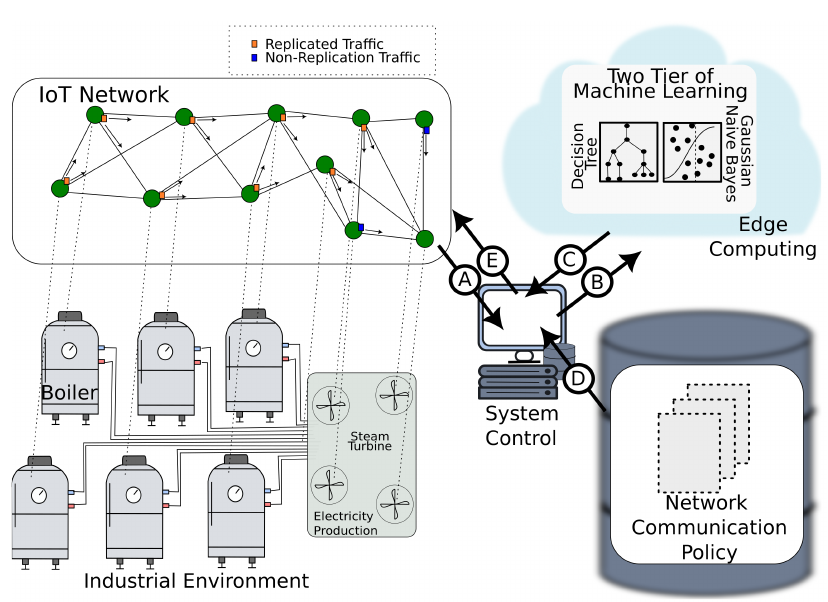
Figure 2. Detection and Alert State for Industrial Internet of Things Faults (DASIF)